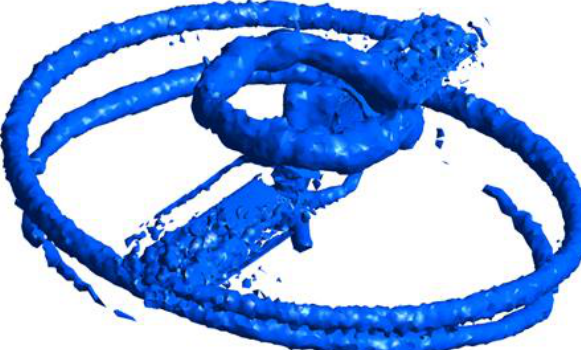
Figure 4. Vorticity contours of flow field in condition 3.